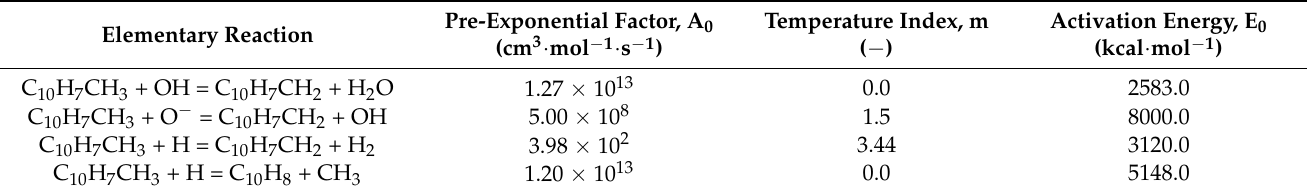
Table A4. Elementary reactions and chemical reaction kinetic parameters related to the C 10 H 7 CH 3